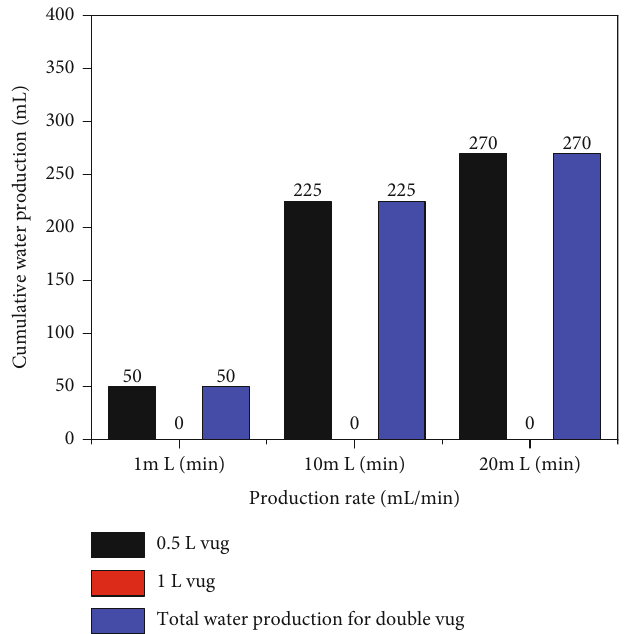
Figure 20: Column chart of cumulative water production in high-pressure physical property experiments under connection type II (di ff erent production rates).